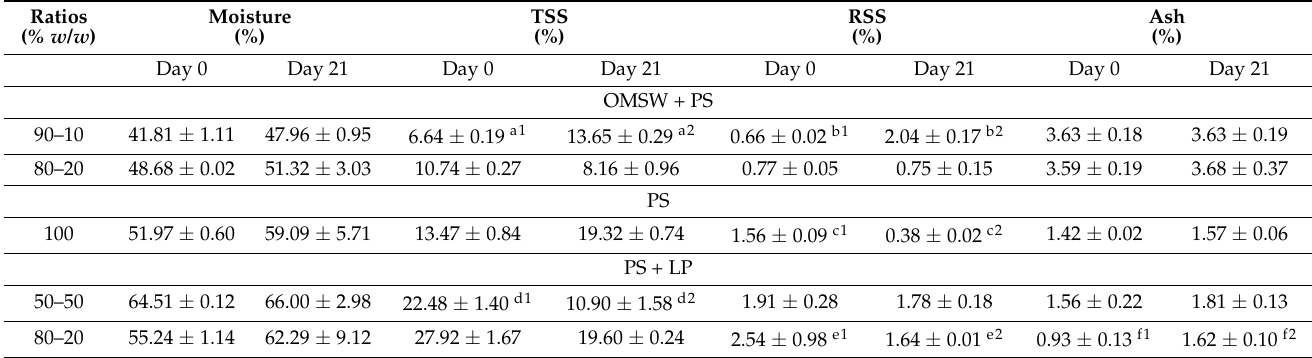
Table 1. Assessment of Physicochemical Parameters for PS and its additions to OMSW and